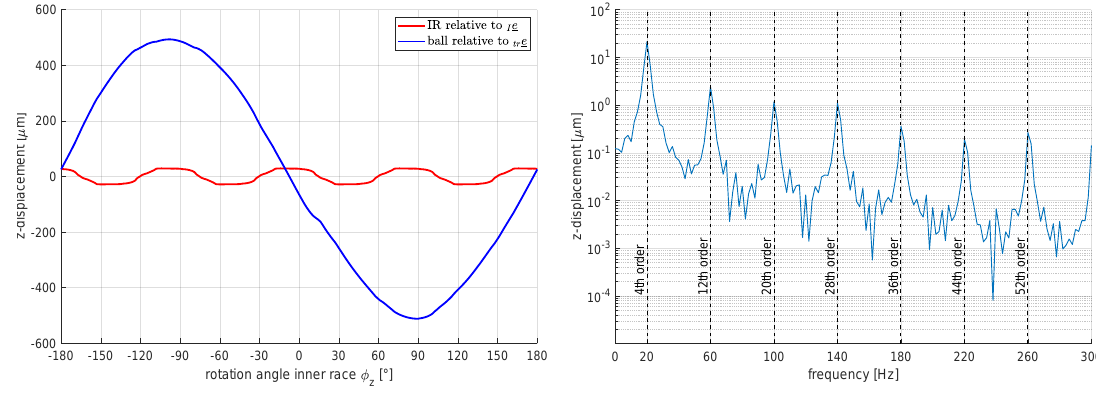
(b) Frequency domain of the axial movement of the inner race Figure 14. Axial movement of the inner